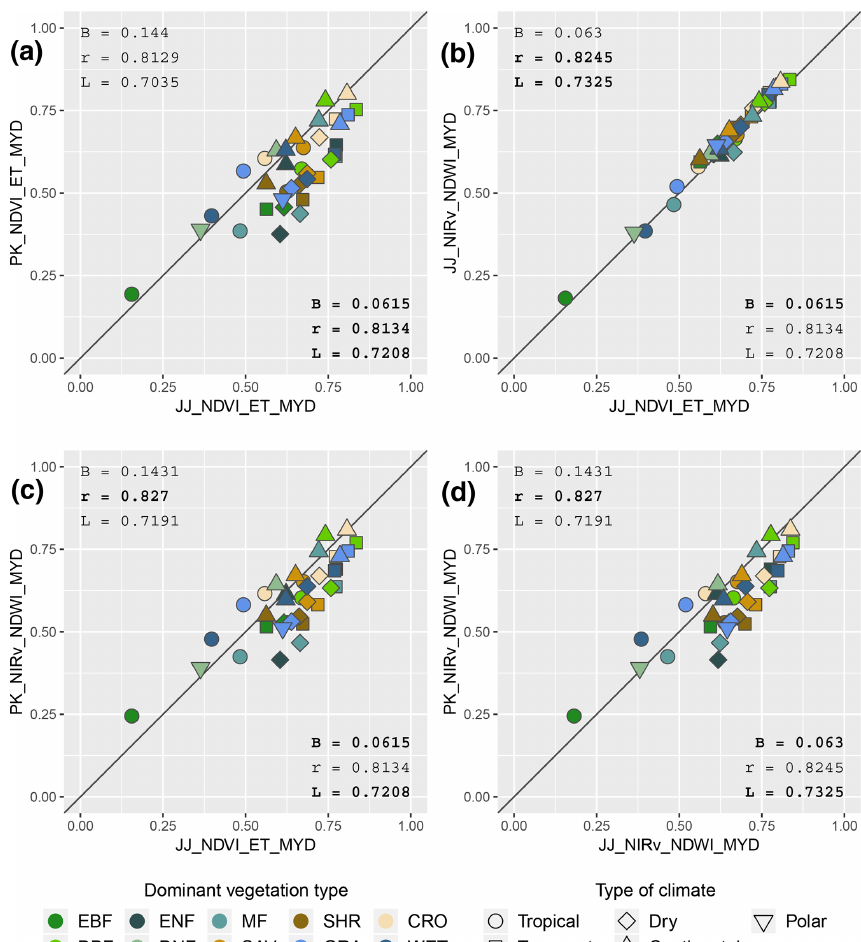
Figure 2. Inter-comparison of the performance of different downscaled products disaggregated per major vegetation type and climate zone. The downscaled products are based on either the PK or JJ retrievals combined with either the old set of explanatory variables (NDVI, ET and MYD) or the new one (NIRv, NDWI and MYD). Each graph plots the agreement of a given downscaled product with OCO-2 over the period 2015–2017 against the agreement of another product with OCO-2 for the same period. The overall bias ( B ), correlation ( r ) and agreement index ( L ) are reported for at the corresponding corner of each graph, with numbers in bold highlighting the better values in each pairwise